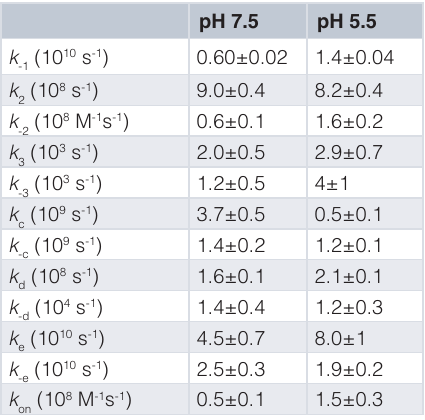
Figure 12. Results of global analysis of the complete course of CO binding kinetics to NP7. ( A : pH 7.5, B : pH 5.5), at T = 20°C and 1 (black) and 0.1 atm (gray). The fits (yellow lines) are superimposed to the experimental data. In the figure, the time course of the other relevant species shown in Figure 8 is reported: DP (black), T T (cyan), T (magenta), NP7 (red) and NP7* 3 4 Table 3. Microscopic rate constants from the global fit of the CO rebinding kinetics at 20°C.